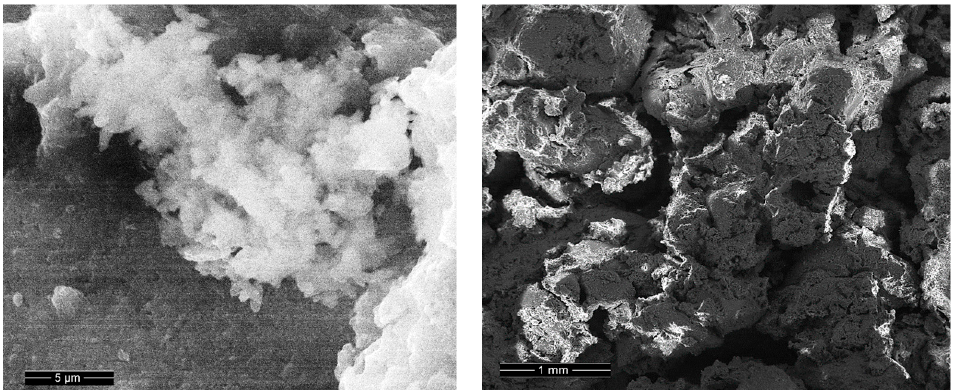
Figure 6. Scanning electron microscopy images for sample A.